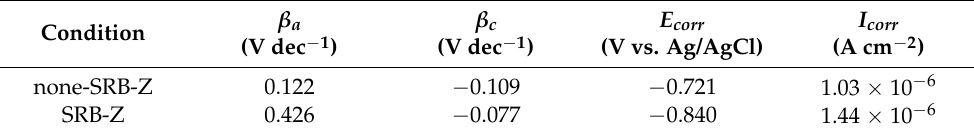
Figure 5. ( a ) Potentiodynamic polarization curves and ( b ) I corr values and standard deviation values of the Q235 on the 7th day in the sterile media and the SRB-Z-inoculated media. Table 3. Fitted parameters of potentiodynamic polarization curves of coupons in sterile and SRB-Z- inoculated media.